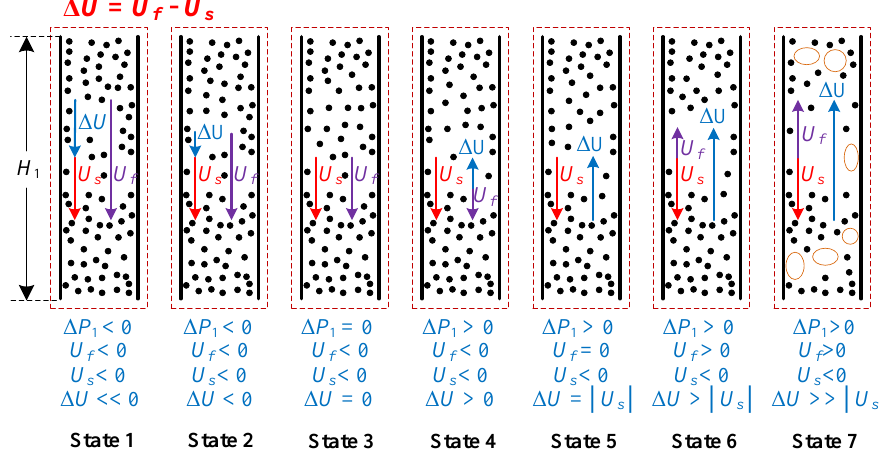
Figure 3. Gas – solid flow diagrams in the upper dipleg under different pressure gradient conditions. Figure 3. Gas–solid flow diagrams in the upper dipleg under different pressure gradient